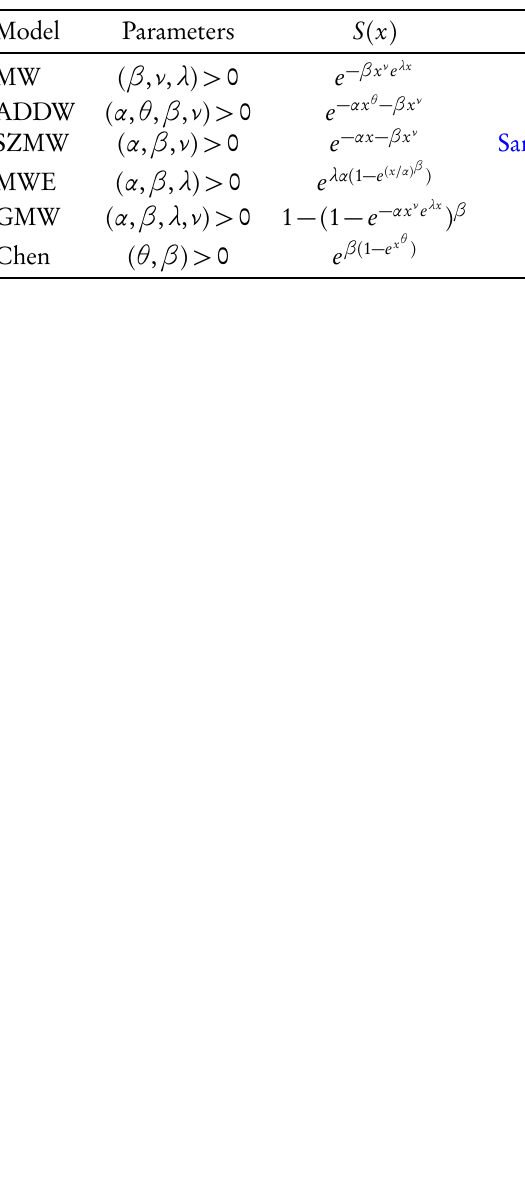
Survival functions of considered